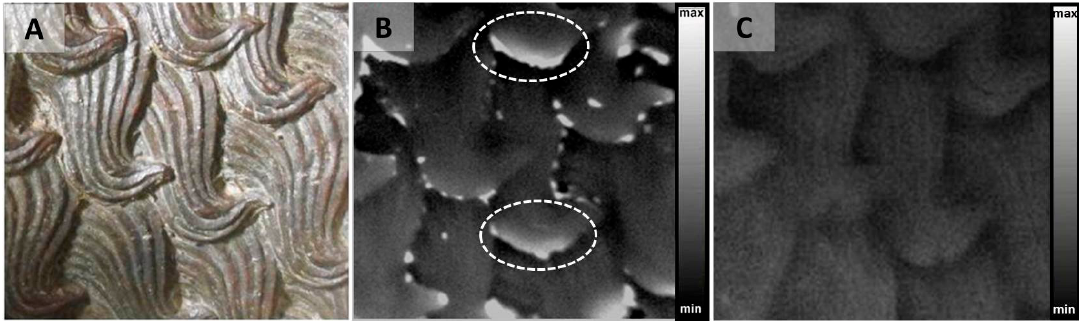
Figure 4 . ( A ) Photograph of the She Wolf fur; ( B ) thermogram of the original statue where ihnomogeneities at the fur edges are highlighted by the dashed circles; ( C ) thermogram of the She Wolf copy where no inhomogeneity is detected [47].